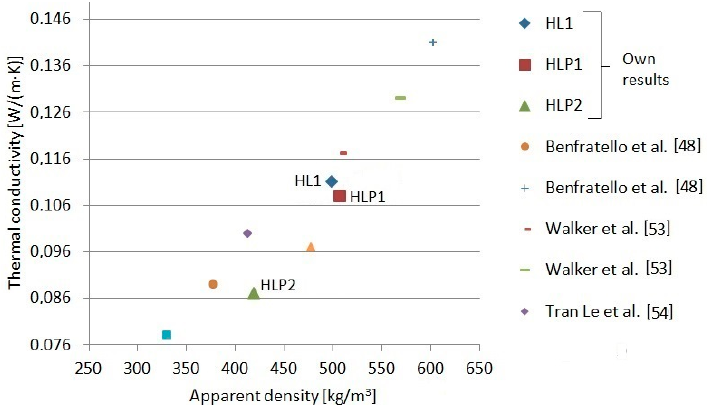
Figure 5. Relationship between the lambda coefficient and the apparent density of the hemp ‐ lime composites [48,53,54].